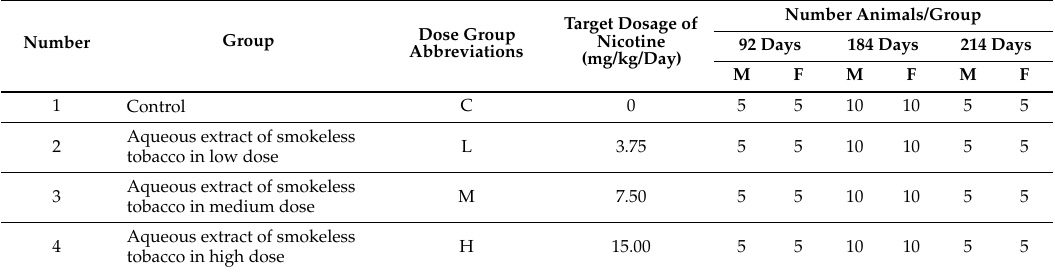
Table 1. 184-Day rat study designs.